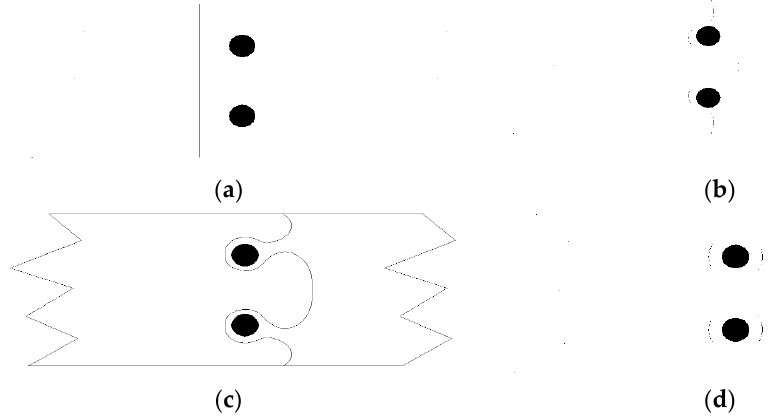
Figure 8. Movement of dislocation bowing through particles: ( a ) initial stage, ( b ) stage II, ( c ) stage III, ( d ) and final stage.